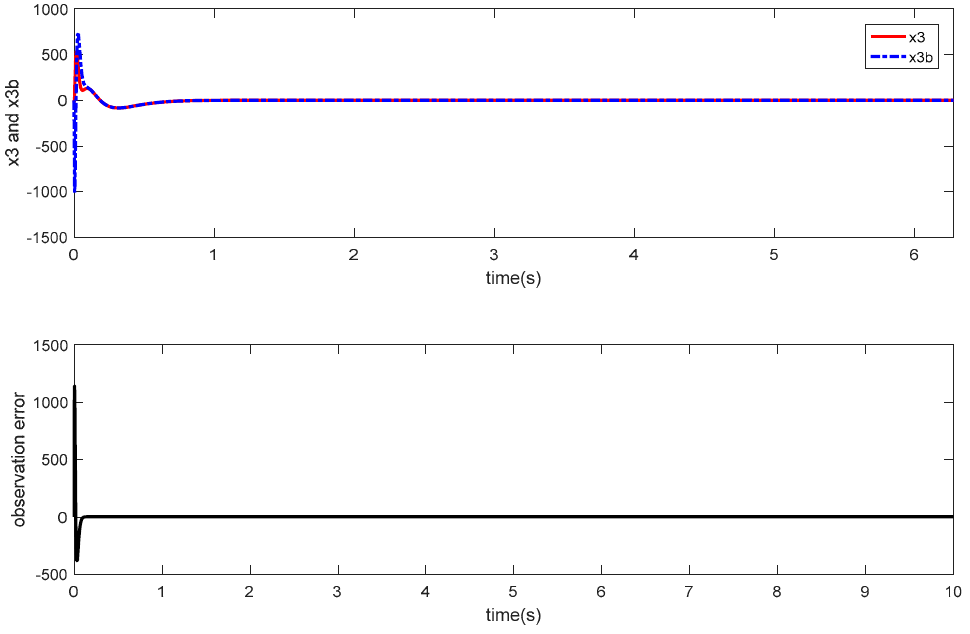
Figure 7. Comparison of the actual and estimated values of the system input.